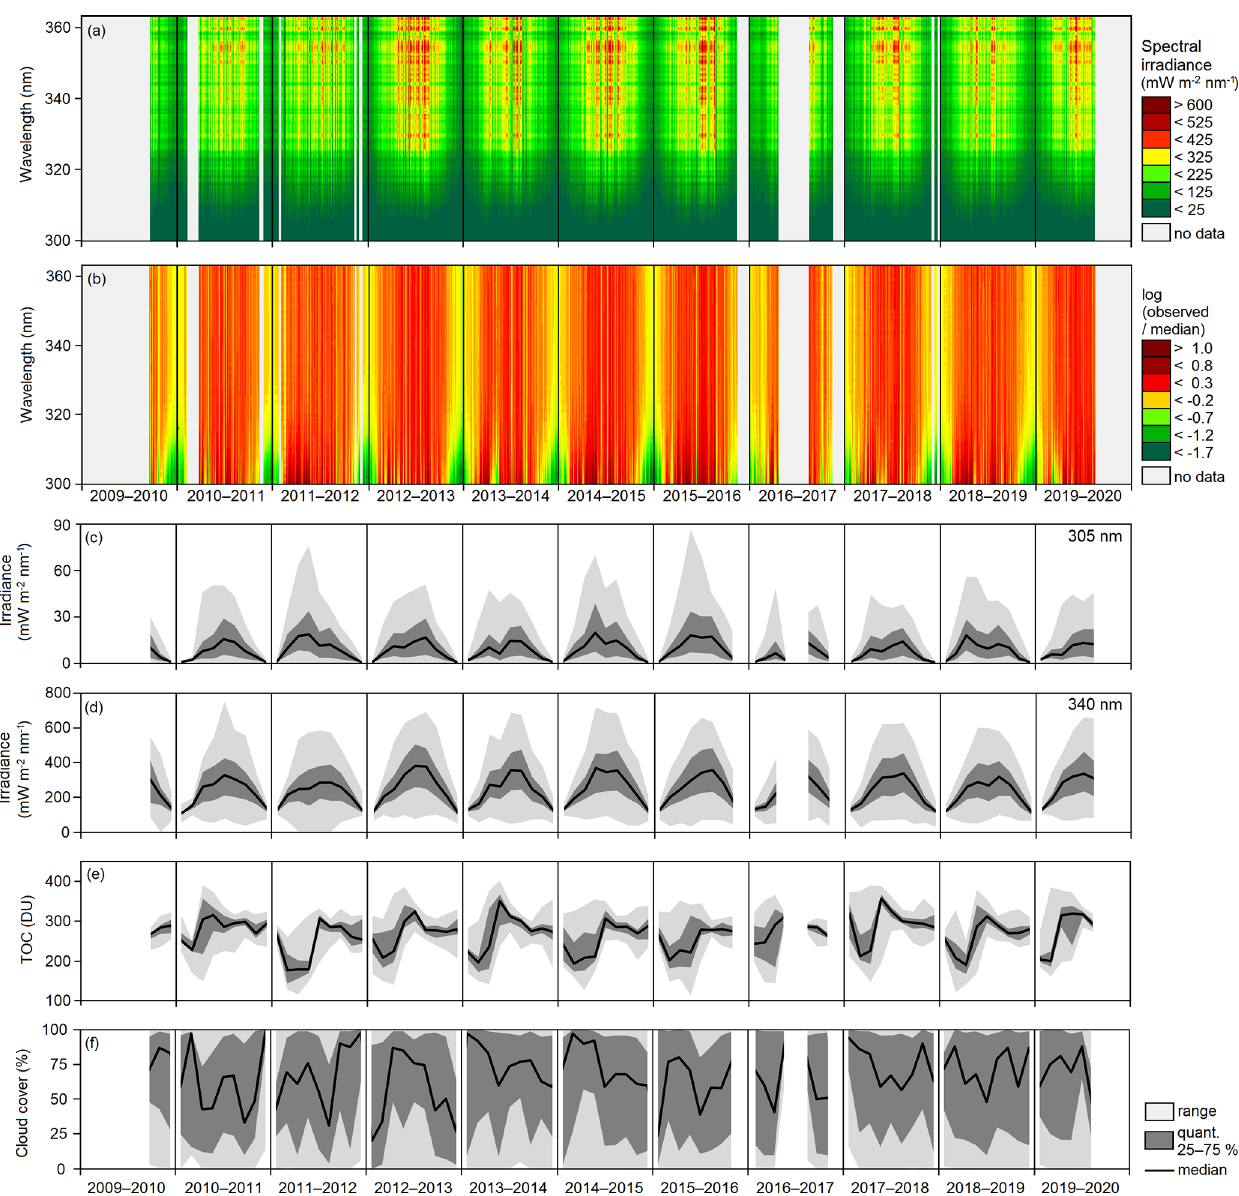
Figure 5. Spectral UV irradiance and related variables at Marambio Base over the period 2010–2020, where (a) represents the daily median intensities of spectral UV irradiance; (b) the daily median spectral UV irradiances relative to the overall median, on a logarithmic scale, at a given wavelength; (c) the monthly variability of solar irradiance at 305nm; (d) the monthly variability of solar irradiance at 340nm; (e) the monthly variability of TOC; and (f) the monthly variability of cloud